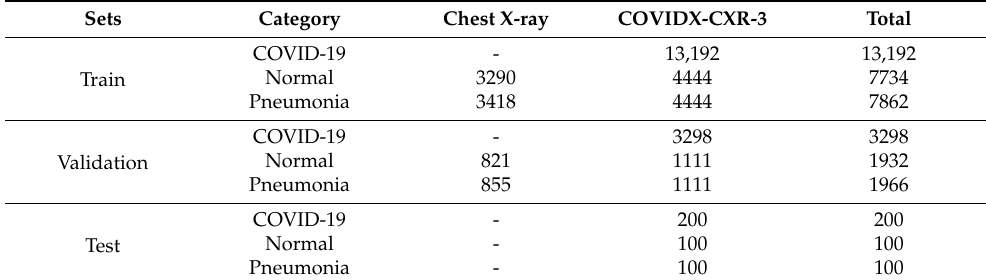
Table 1. Detailed description of the COVID-19 classification dataset from the Chest X-ray and COVIDX-CXR-3